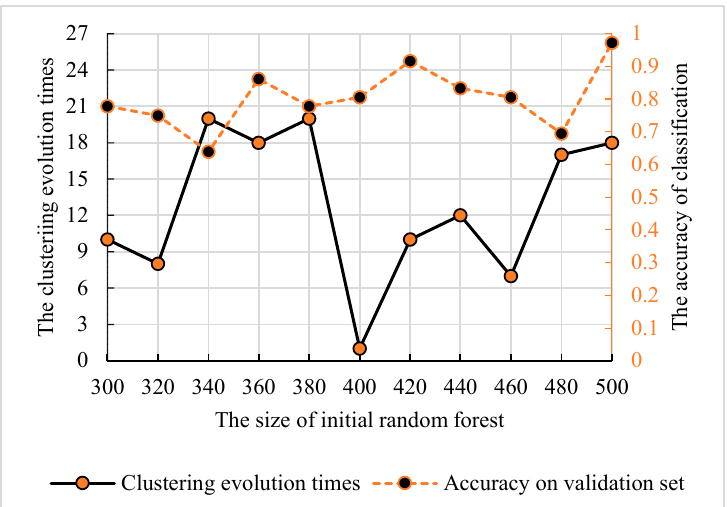
Figure 8. The relationship between the clustering evolution times and the size of initial random forest. The dotted line indicates the accuracy of classification. The solid lines indicate the number of clustering evolution times according to the initial random forest size.